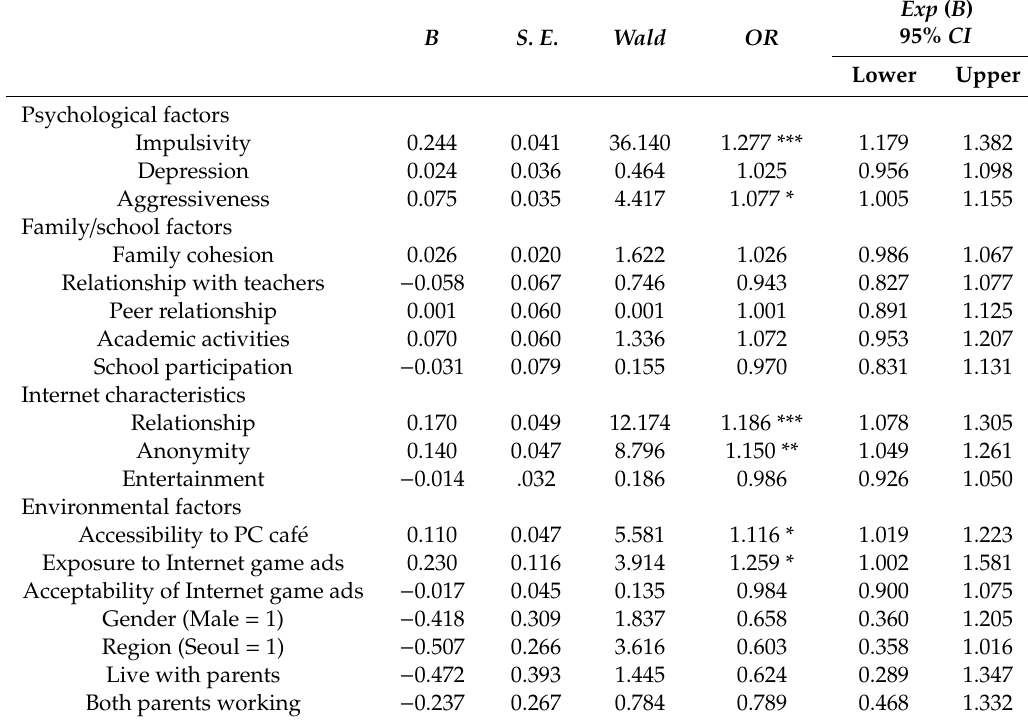
Table 4. Logistic regression analysis of factors influencing Internet